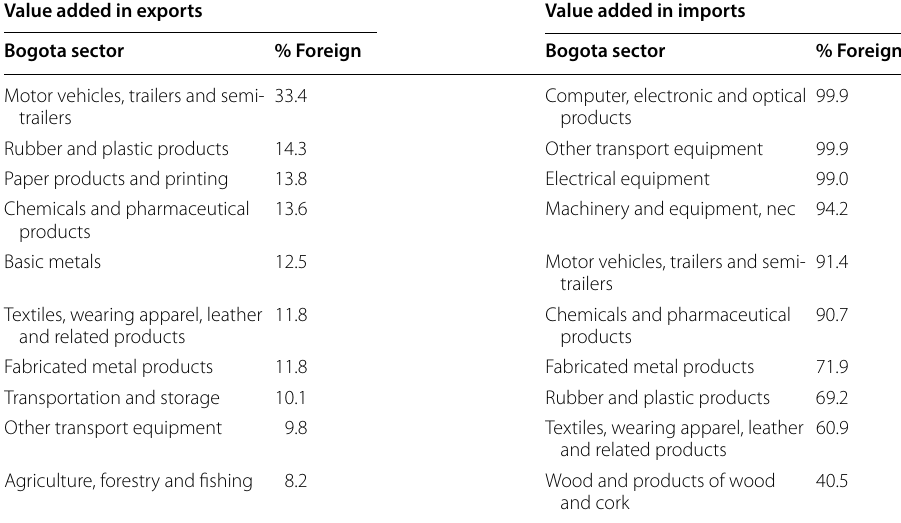
Table 7 Bogota top 10 industries according to their foreign share in value added Value added in exports Value added in imports Bogota